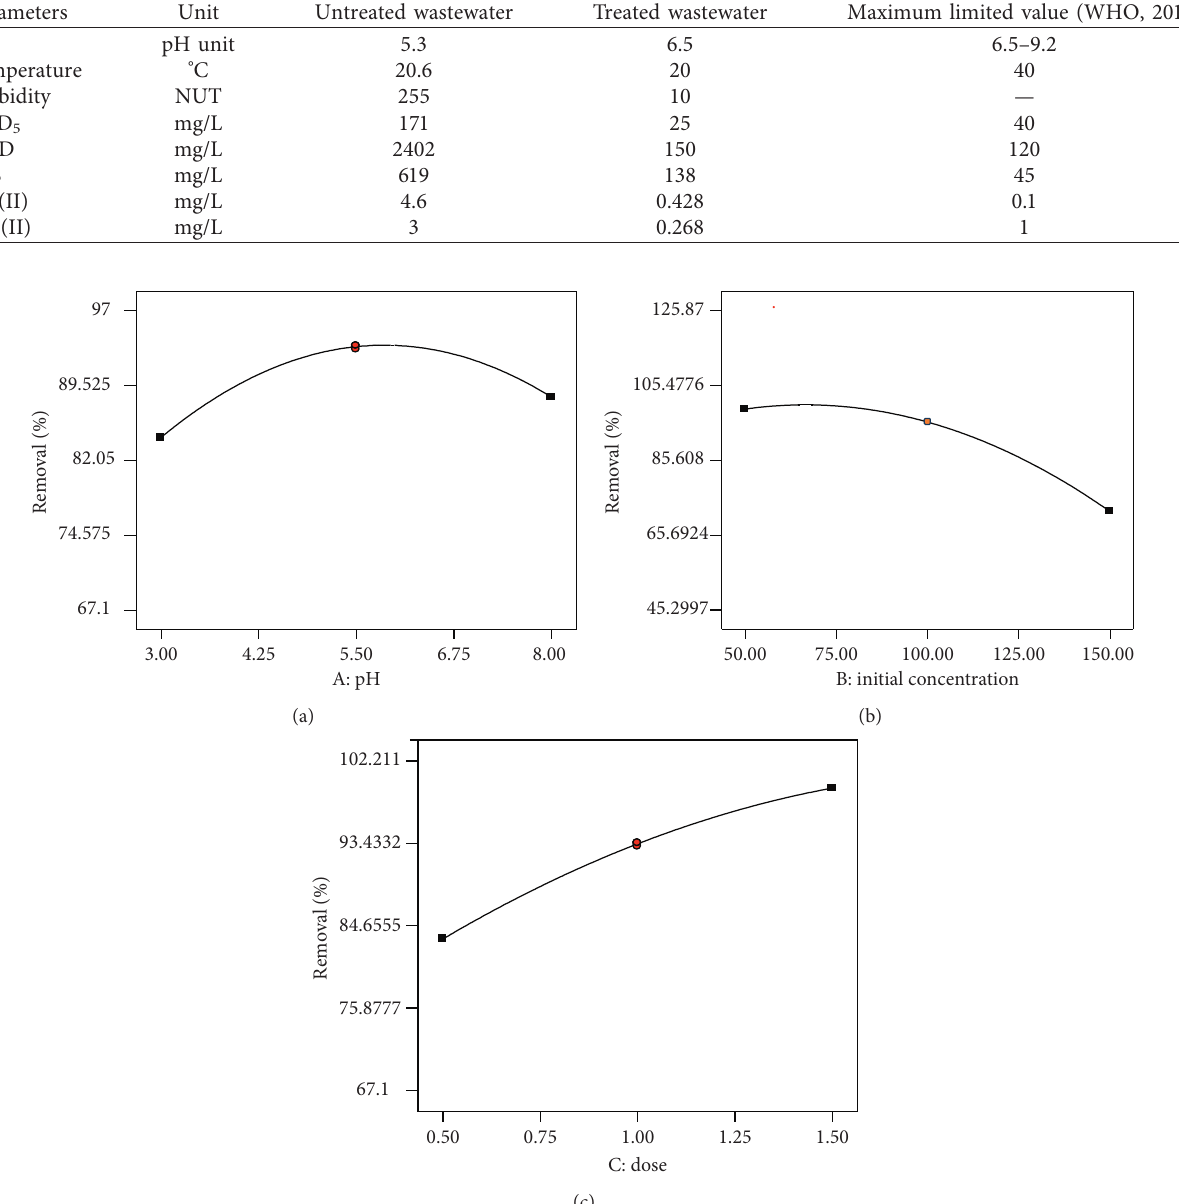
Table 4: Paint industry wastewater (untreated and treated) characteristics.